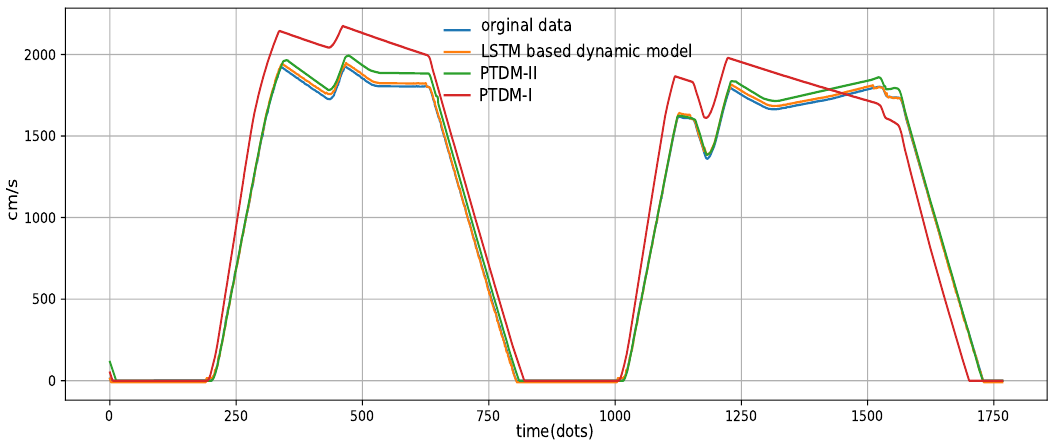
Figure 6. Comparison of different